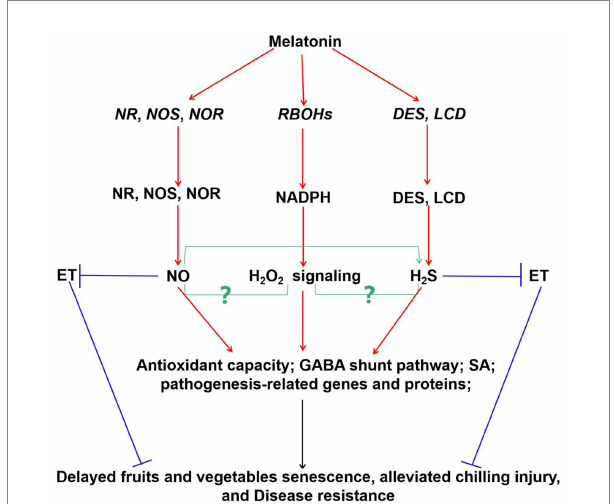
FIGURE 2 Probable integrative model of melatonin and signaling molecules (H 2 O 2 , NO, and H 2 S) in postharvest protection of fruits and vegetables during storage period. Increasing evidences showed that melatonin enhanced the expression of RBOHs , NR , NOS , NOR , DES , and LCD genes, and induced H 2 O 2 , NO, and H 2 S generation, thereby activating the signaling pathways in fruits and vegetables. Besides, hormones were also involved in these pathways to regulate fruits and vegetables quality. Interaction between NO and H 2 S was also suggested. The relationships between the H 2 O 2 signaling and NO/ H 2 S in postharvest protection of fruits and vegetables are still largely unknown (green arrow, yet largely unknown). Red arrow, induced; blue arrow, inhibited. Respiratory burst oxidase homologs (RBOHs), nitrate reductase (NR), nitric oxide synthase (NOS), desulfhydrase, (DES), L -cysteine desulfhydrase (LCD), nitric oxide (NO;), hydrogen peroxide (H 2 O 2 ), hydrogen sulfide (H 2 S), ethylene (ET), salicylic acid (SA), γ -aminobutyric acid